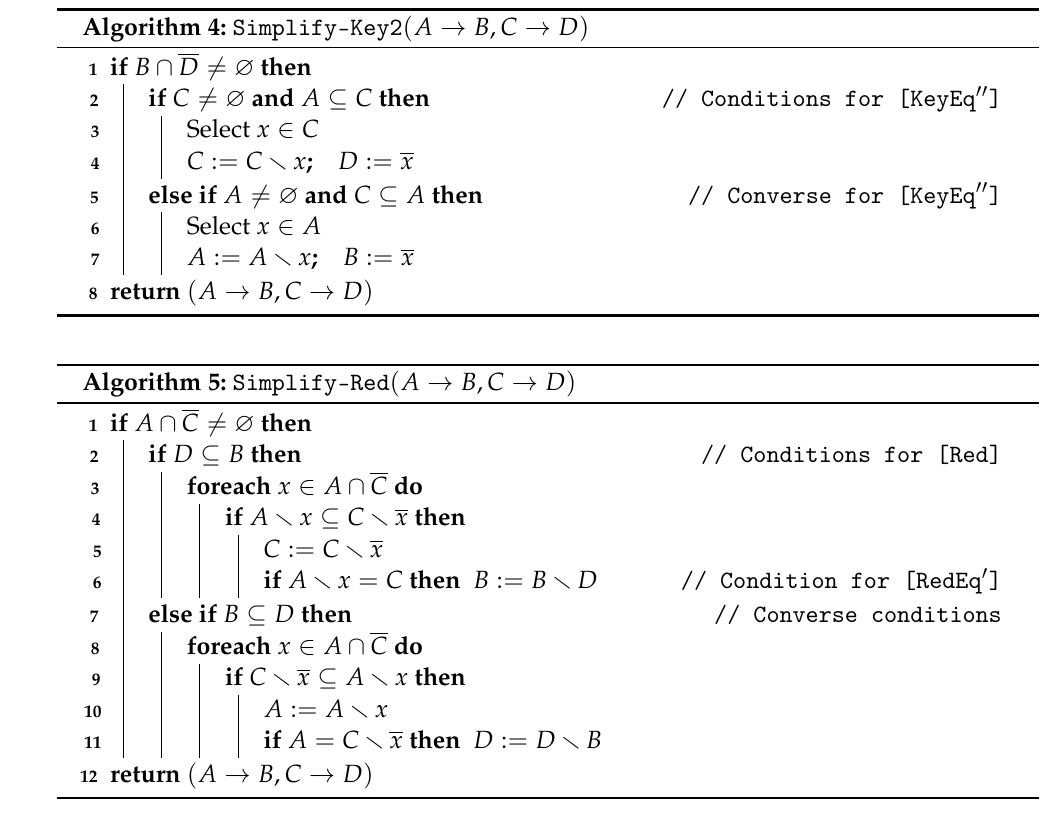
Algorithm 4: Simplify-Key2 ( A